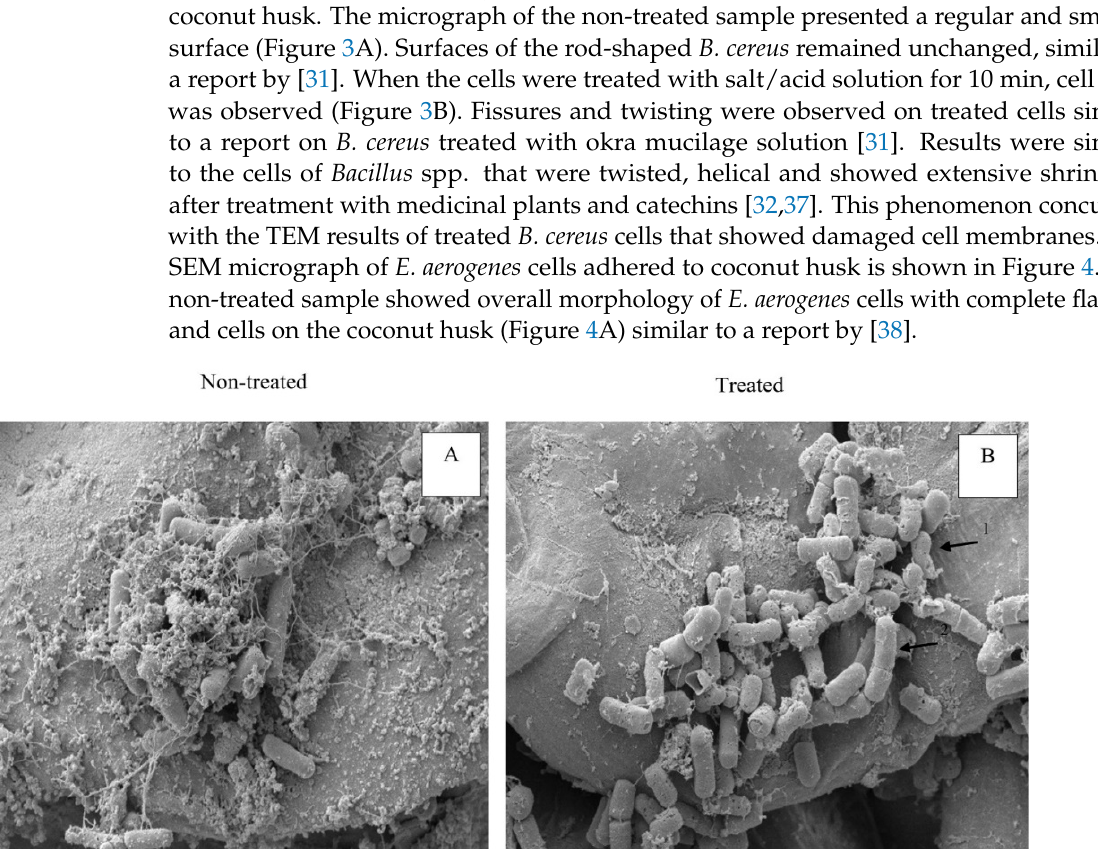
Figure 4. Scanning electron micrographs of E. aerogenes on coconut husk at 5000× magni fi cation; non-treated ( A ) and treated with 15:20% ( w/v ) salt/acid solution for 10 min ( B ), respectively. Holes on cell surface (arrow #1).